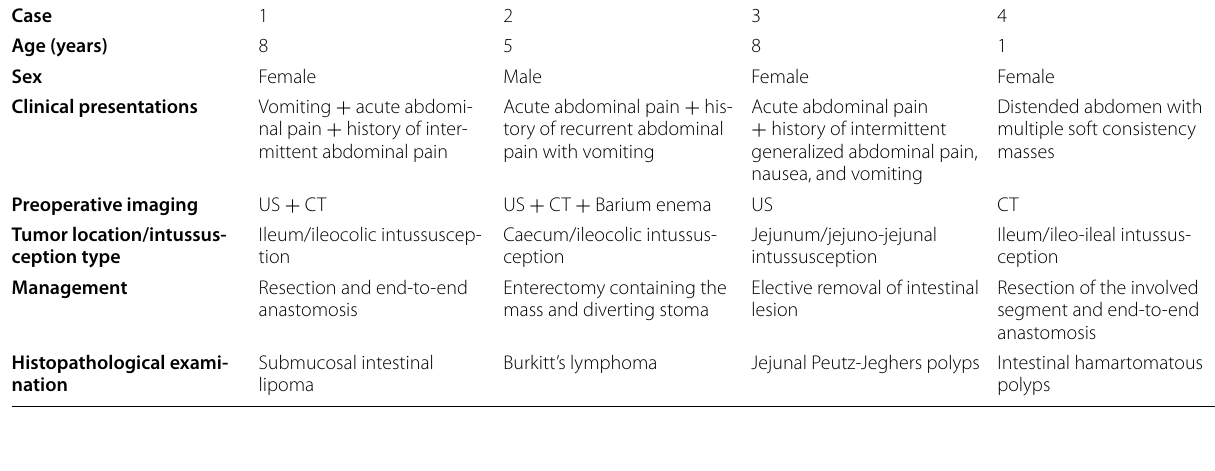
Table 1 Characteristics of the four cases of intussusception secondary to IT lesions